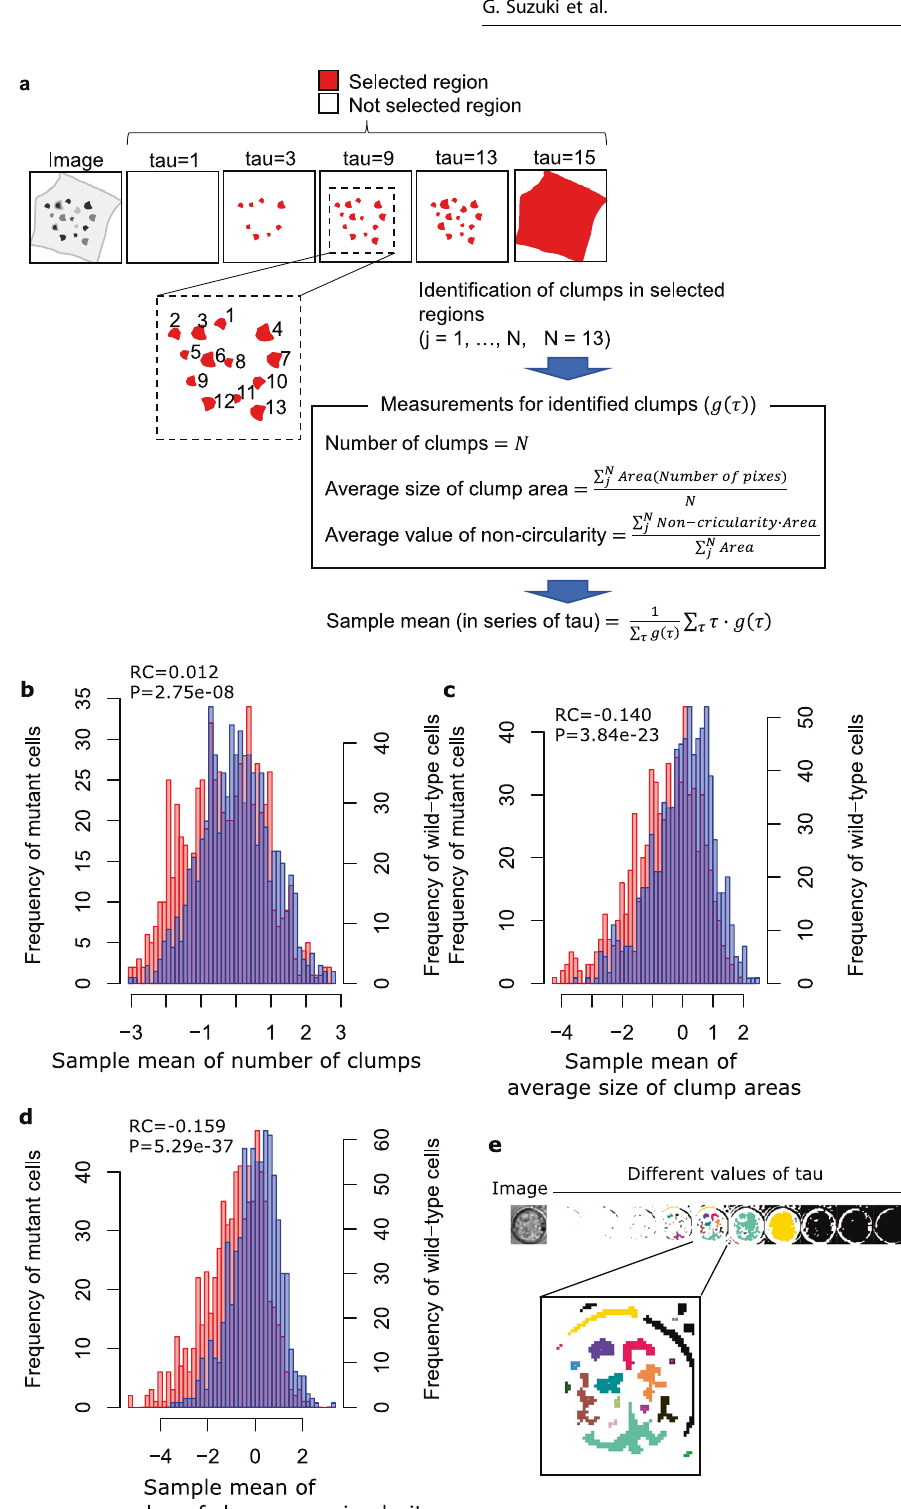
Fig. 3 Examples of the large-weight features in the discriminative model for PSMB5 mutant cells. a Schematics of the feature extraction procedure from BF images. Tau indicates a threshold of pixel value to identify clumps within a cellular region as described previously 15 . b Distribution of PSMB5 mutant cells and wild-type cells on the feature “ sample mean of number of clumps ” . Blue and red histograms represent mutant and wild-type cells, respectively. P value of one-sided U test between mutant and wild-type cells, and the regression coef fi cient (RC) in the logistic regression model are shown. c Distribution of PSMB5 mutant cells and wild-type cells on the feature “ sample mean of average size of clump areas ” shown in the same way as in b . d Distribution of PSMB5 mutant cells and wild-type cells on the feature “ sample mean of average value of noncircularity ” shown in the same way as in b . e Example of clump detection using an image of a wild-type cell. The leftmost panel is an input cellular image, and the right panels are those processed with different thresholds. In the magni fi ed panel, each clump is shown in a different